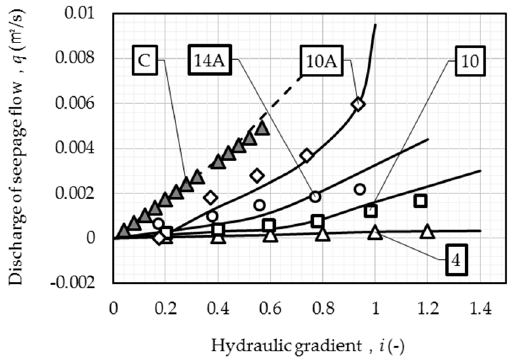
Figure 9. Verification: dashed lines for computation results of runs in Skempton and Brogan [9]; solid lines for computation results of runs in Wan and Fell [1]; solid points for test results of runs in Skempton and Brogan [9]; and hollow points for runs in Wan and Fell [1].